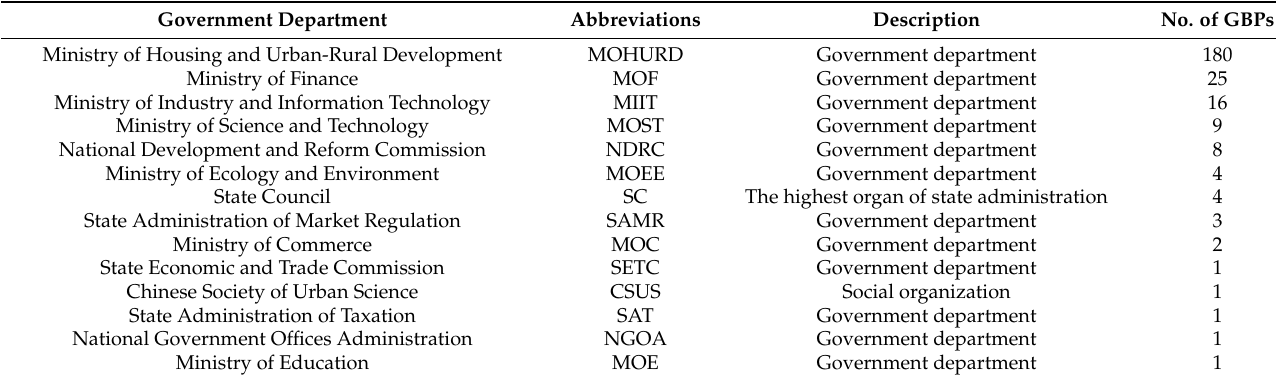
Table 1. Green building (GB) policymaking agencies in China from 1986 to 2019.